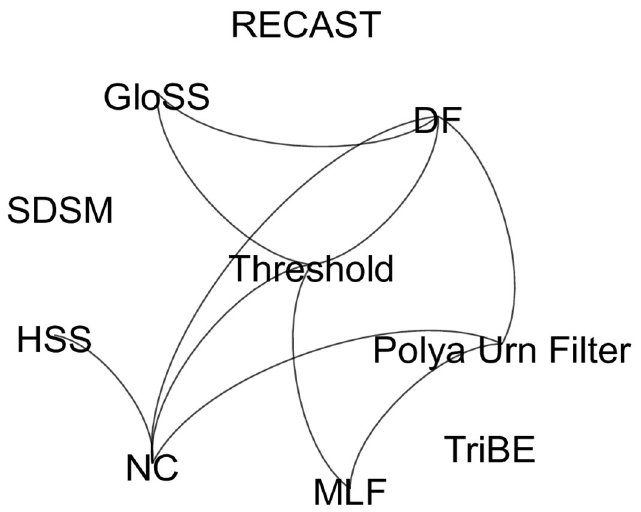
Fig 1. Selected backbone extraction methods: Edges connect methods already compared to each other in prior work. Details of each methods are provided in Table 1.